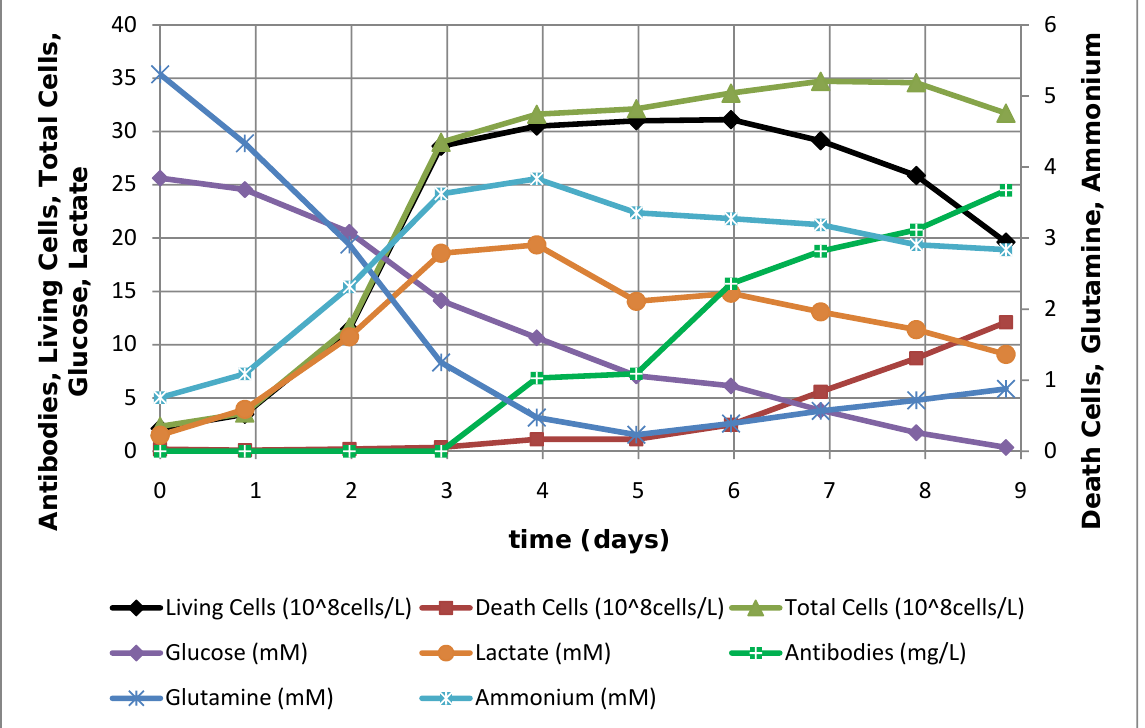
Figure 24: Experimental data of CHO-Cells growing in shaking